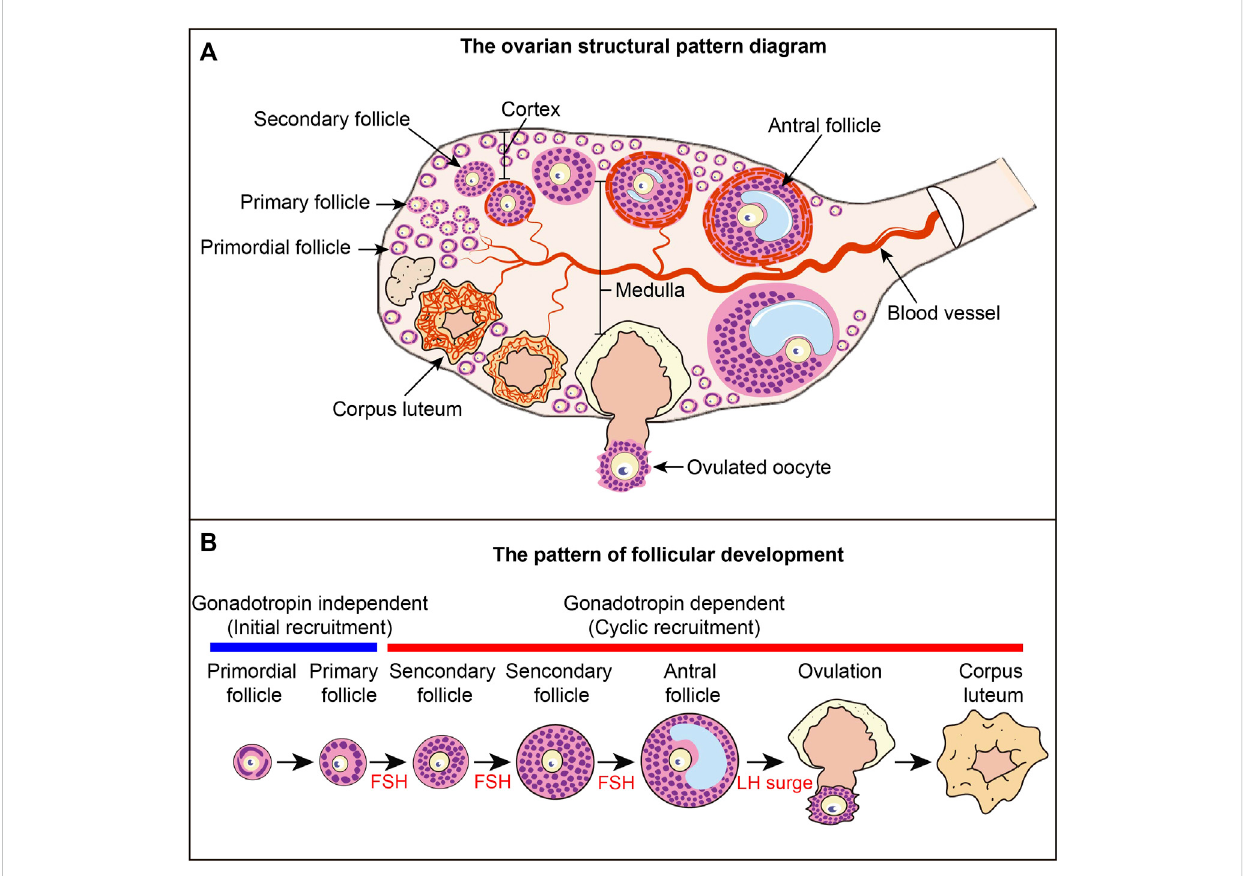
Ovarian structure and follicular development pattern diagram (A) Ovarian structural pattern diagram. Follicles at different developmental stages constitute the basic structural and functional unit of the ovary. Primordial follicles are mainly distributed in the cortex, and growing follicles are mainly distributedinthemedulla.Thebloodvesselsintheovaryprovidenutrientstotheovariantissueandfollicles,andthebloodvesselsaroundeachfollicleare relatively independent. (B) Follicular development pattern. The development of primordial follicles into primary follicles is independent of gonadotropins, a process called primordial follicle activation, also known as initial recruitment. The process from primary follicle development to ovulation is a gonadotropin-dependent stage. The process of primary follicle development into preantral follicles is called cyclic recruitment and is the